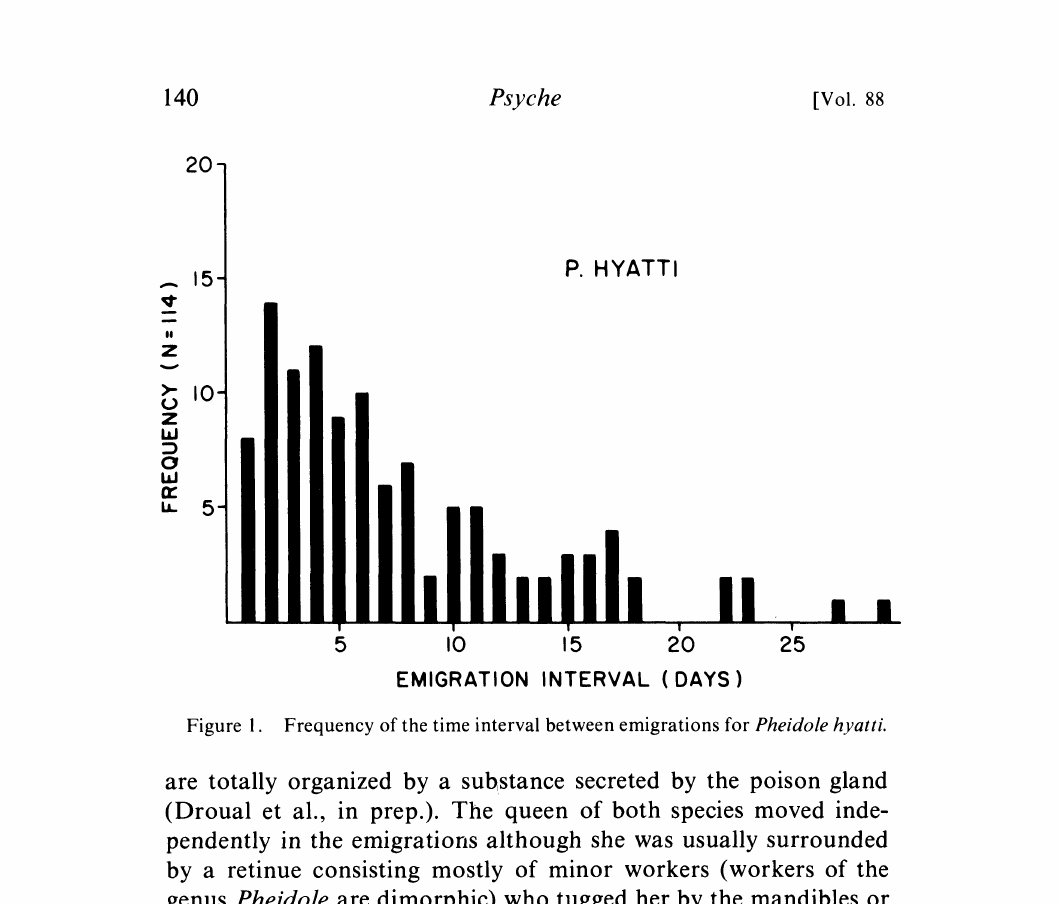
Figure I. Frequency of the time interval between emigrations for Pheidole